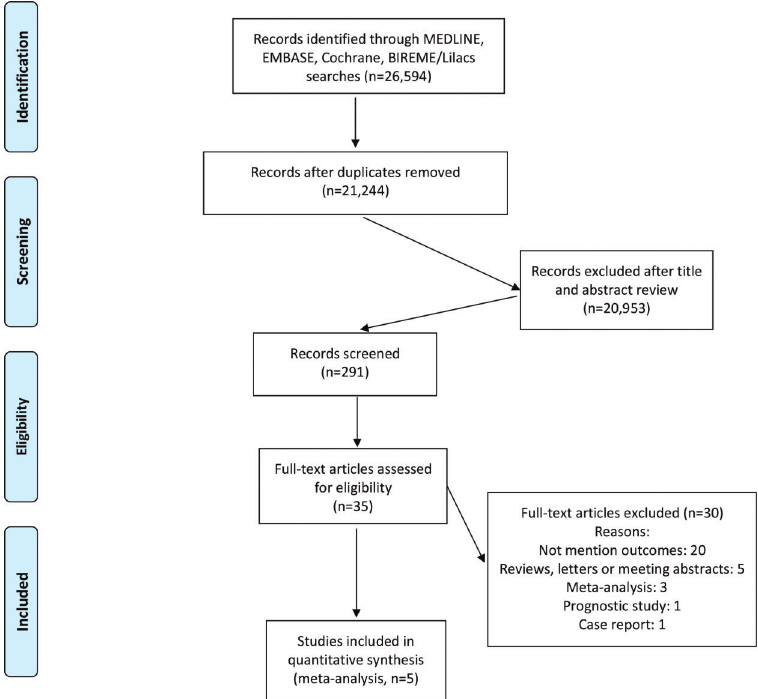
Figure 1 - Prisma Flow